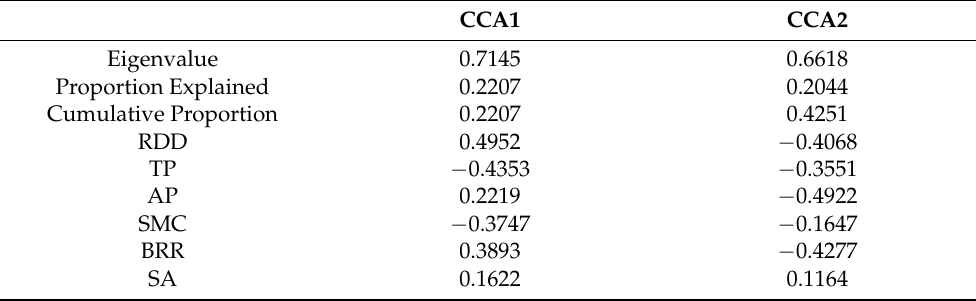
Figure 3. The CCA ordination diagram of plant communities and environments in the rocky deser- tification study plots in northern Guangdong. The blue arrows represent various environmental parameters. The red “+” represents the distribution of different species Note: slope (SA), bedrock exposed rate (BRR). sp1, Glycosmis pentaphylla ; sp2, Tinospora sagittate ; sp3, Endospermum chinense ; sp4, Melodinus cochinchinensis ; sp5, Sterculia lanceolata ; sp6, Adenanthera microsperma ; sp7, Ilex aculeolate ; sp8, Dalbergia benthamii . Table 5. The eigenvalues of the CCA ordination axes and their correlations with the environmental factors.